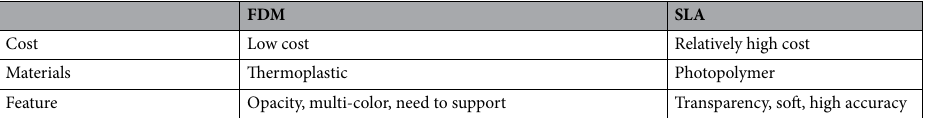
FDM SLA Cost Low cost Relatively high cost Materials Thermoplastic Photopolymer Feature Opacity, multi-color, need to support Transparency, soft, high Table 2. Comparison of two types of 3D printing, including FDM and SLA. 3D three-dimensional, FDM fused deposition modeling, SLA stereolithography.